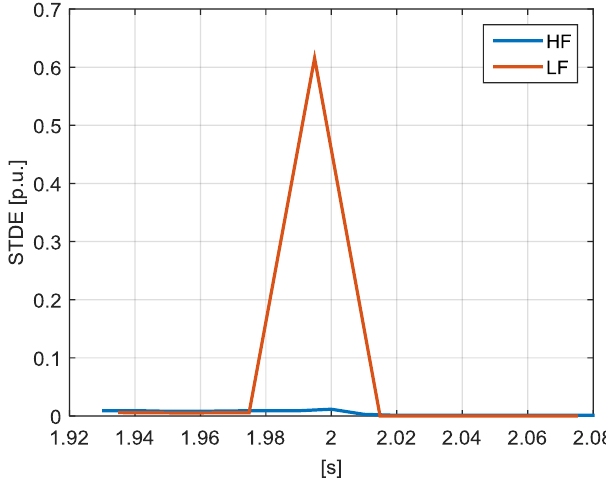
Figure 22. Case study 3: STDE at low-frequency (0 ÷ 2.4 kHz, red line) and at high-frequency (2.4 ÷ 150 kHz, blue line) obtained through the late approach.